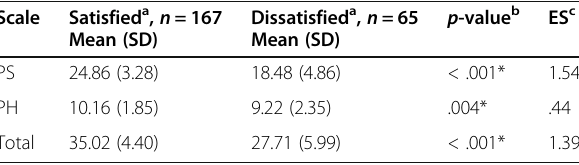
Table 7 Nuss Questionnaire modified for Adults: known-groups